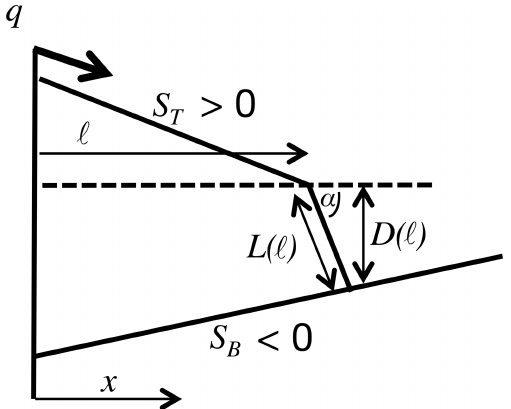
Figure 1. Schematics of sediment delta cross sections depositing on to a fixed basement with an adverse slope S B < 0. The top set slope is S T > 0 and the submarine foreset has angle α , length L ( (cid:96) ), and a depth of D ( (cid:96) ) at the point where its toe touches the